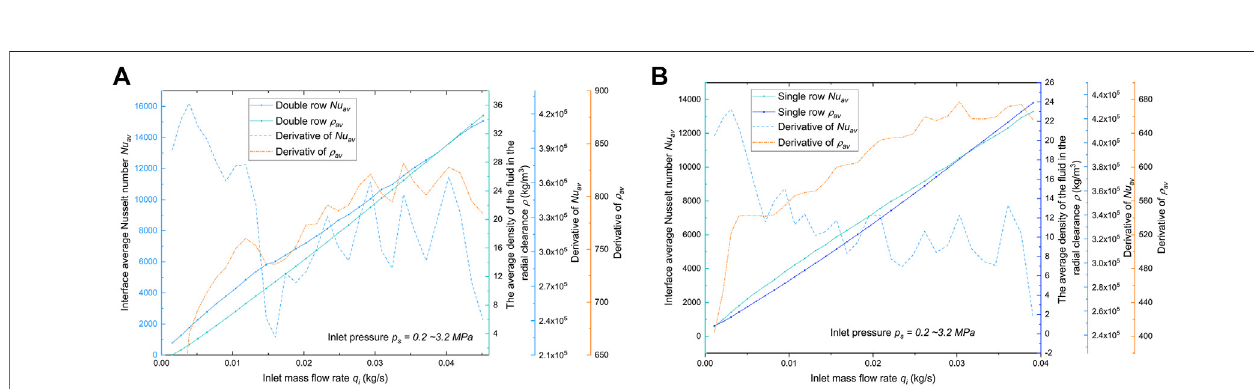
FIGURE3| Convectionheattransferperformanceofdual-rowandsingle-rowcoolers: (A) InterfaceaverageNusseltnumber Nu av andinletmass fl owrate q i versus inlet pressure p s . (B) Nu av and Average density of gas in the radius clearance ρ av versus inlet pressure p s .